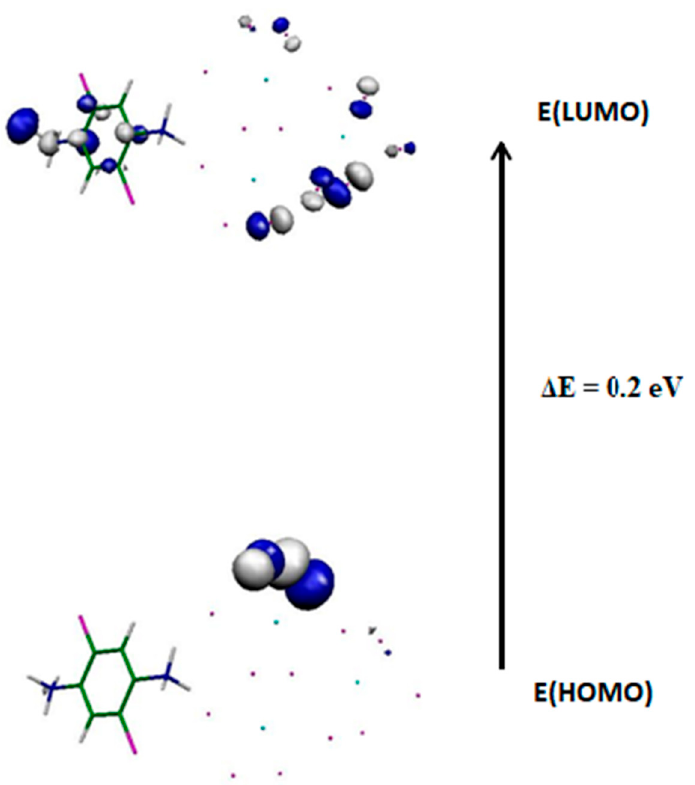
Figure 12. Frontier molecular orbitals in (C 6 H 8 Cl 2 N 2 ) 2 [Cd 3 Cl 10 ] · 6H 2 O.